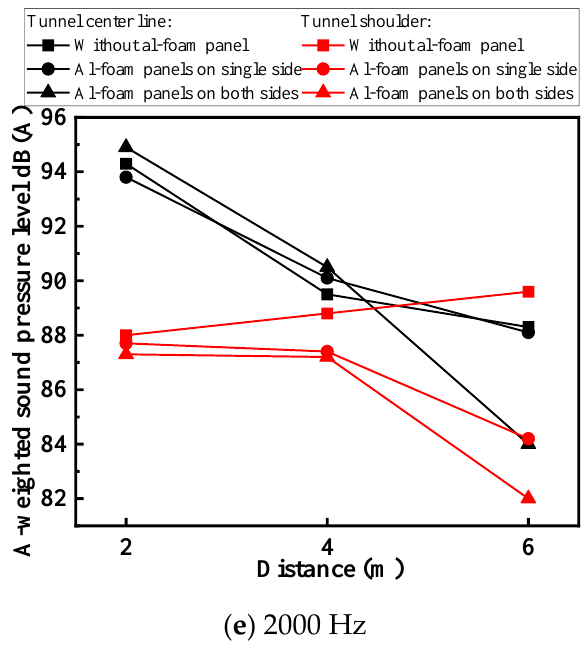
Figure 9. Influence of location and distance.